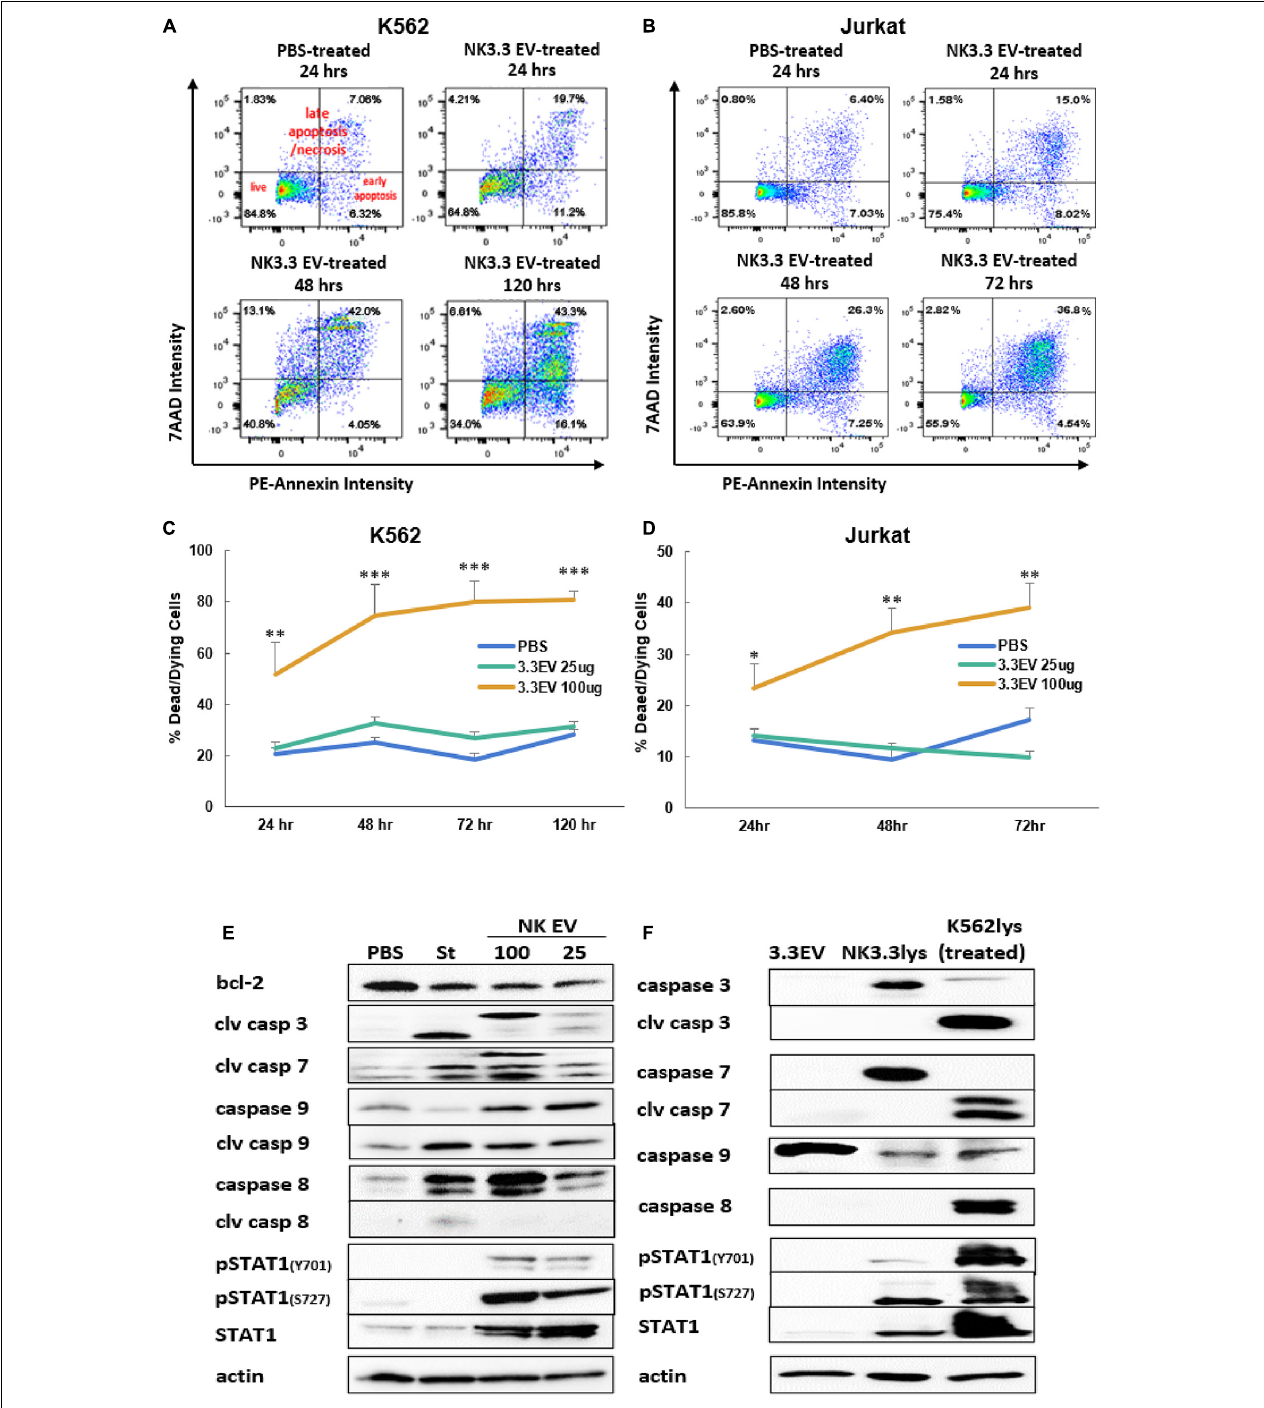
FIGURE 6 | Induction of apoptosis in leukemia cells and alterations in K562 protein expression by treatment with NK3.3-derived EVs. Leukemia cells treated with either PBS, 25 or 100 µ g/ml NK3.3 EVs were stained for annexin V and 7-AAD and analyzed by flow cytometry. Representative scatter plots are presented for (A) K562 cells and (B) Jurkat cells. Graphs of the cumulative apoptosis data collected by flow cytometry are shown for (C) K562 cells and (D) Jurkat cells. Dying/dead cell frequency is the sum of all annexin V- and 7AAD-positive quadrants. Mean frequency ± SE; n = 6. ∗ p ≤ 0.05, ∗∗ p ≤ 0.005, ∗∗∗ p ≤ 0.0005. (E) Immunoblots of K562 protein lysates from cells treated for 24 h with PBS, 2.5 µ M staurosporine (St), 100 µ g/ml NK3.3 EVs (100), or 25 µ g/ml NK3.3 EVs (25); 25 µ g protein per lane was used. (F) Comparison of protein expression from NK3.3-derived EVs (3.3EV), NK3.3 cells (NK3.3lys), or K562 cells 24 h post- 100 µ g/ml NK3.3 EV treatment (K562lys). Lysates were prepared, and immunoblotting performed to assess the potential contribution of NK EV-associated proteins to NK EV-treated K562 cells (25 µ g of protein per lane).